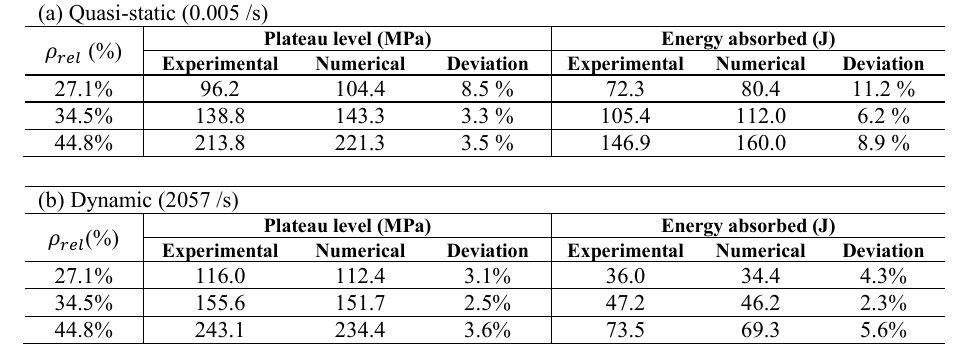
Tab. 3. Summary of plateau level and energy absorbed for the SD TPMS at (a) quasi-static and (b) dynamic strain rates.